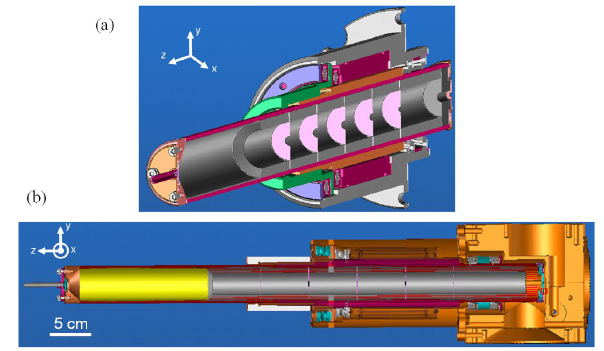
Fig. 2. Scheme of the aerodynamic lens system of SPLAM and its z -translation mechanism (vertical cuts). (a) View of the five lens orifices and the relaxation chamber. (b) View of the ALS integrated into the first two pumping stage regions (drawings: